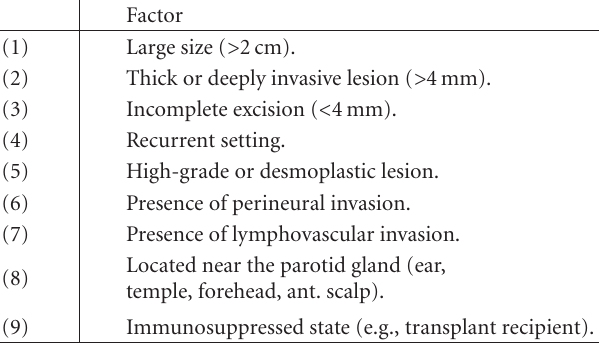
Table 1: High-risk factors (patients often have multiple high-risk factors